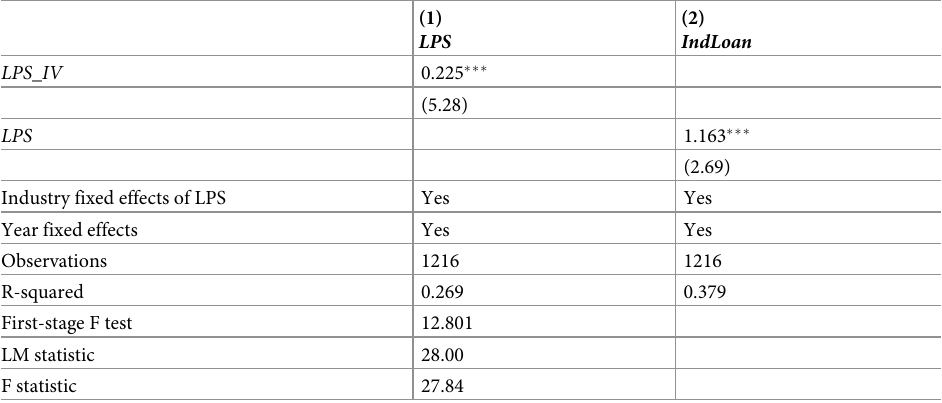
Table 6. The largest private shareholder and bank loans: IV estimation. This table reports the estimation results from 2SLS regressions analyzing impact of the largest private shareholder on bank lending to their industry, with industry fixed effect of the largest private shareholder and year fixed effect. Column 1 is the first stage regression of LPS on LPS _ IV . Columns 2 is the second stage results. Columns 2 use IndLoan as the dependent variable. Variables are defined in S1 Appendix. The sample period is from 2007 to 2020. In parentheses are t-statistics. ��� , �� , � indicate statis- tical significance at the 1%, 5%, and 10% level,